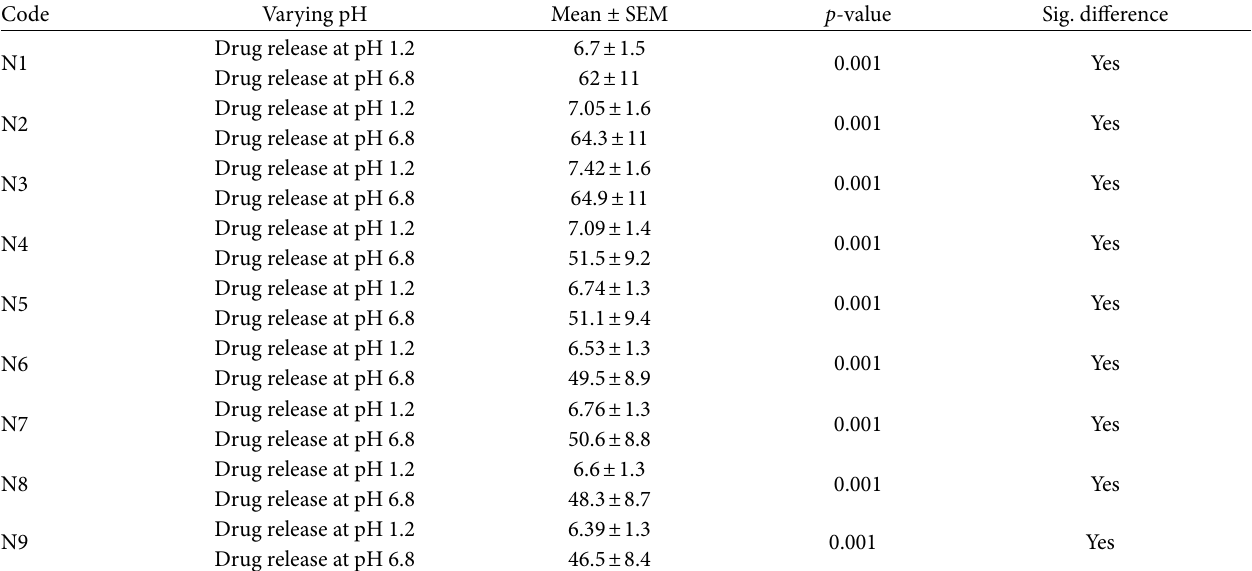
Table 8: Comparison between drug release of all formulation at pH 1.2 and pH